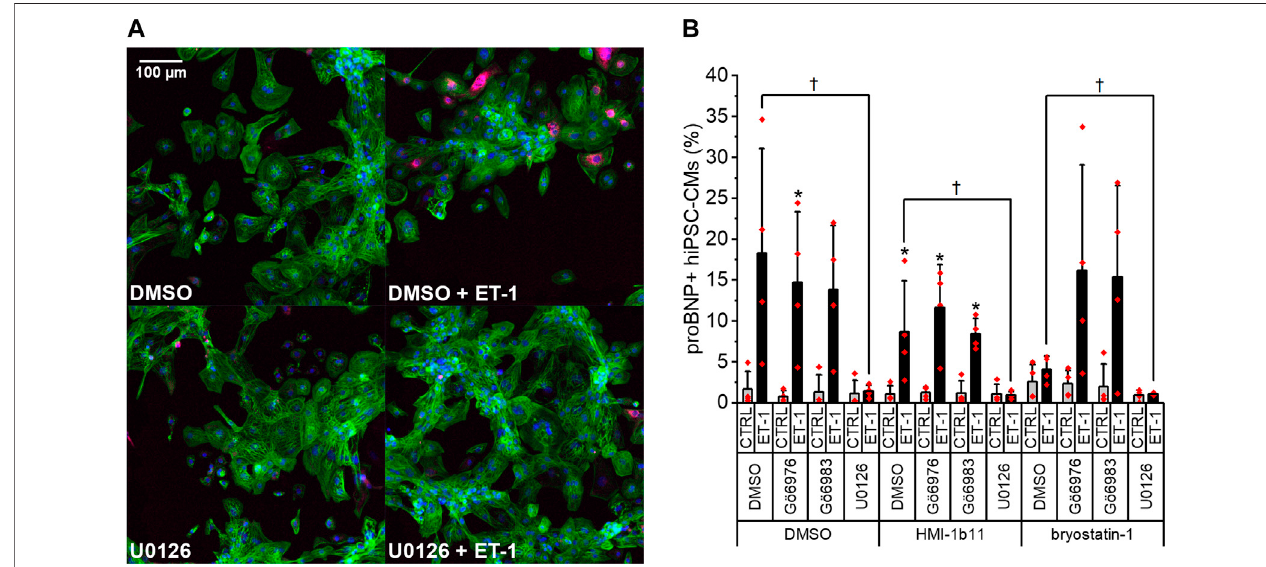
FIGURE 4 | Effects of endothelin-1 (ET-1) and pharmacological PKC and MEK1/2 modulation on pro-B-type natriuretic peptide (proBNP) expression in human induced pluripotent stem cell-derived cardiomyocytes (hiPSC-CMs). (A) Representative images of DMSO, U0126 and ET-1 treated hiPSC-CMs stained for DAPI (blue), cardiactroponinT(green)andproBNP(magenta). (B) PercentageofproBNPpositivecellsisbasedonaverageintensityofproBNPstainingintheperinuclearregionafter a 24-h exposure to PKC activators (10 µM HMI-1b11 and 10 nM bryostatin-1), cPKC inhibitor (1 µM Gö6976), pan-PKC inhibitor (1 µM Gö6983) and MEK1/2 inhibitor(10µMU0126)withorwithout100 nMET-1.Resultsareexpressedasmean+SDoffourindependentexperimentswithCMsfromfourindividualdifferentiations (day 35 – 48). * p < 0.05 for ET-1 vs. respective CTRL; † p < 0.05 as indicated (Kruskall-Wallis followed by Mann-Whitney